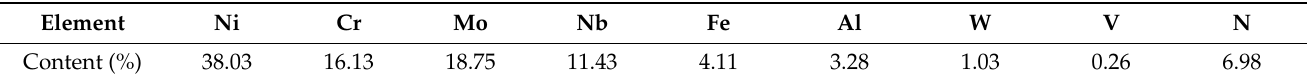
Figure 9. Surface and cross-sectional morphology of 3 nitrogen-containing low-nickel weld cladding after corrosion for 10 h. ( a ) SEM surface morphology. ( b ) High magnification of area A. ( c ) EPMA section morphology and corresponding elemental maps. Table 4. Surface element content of nitrogen-containing low-nickel weld cladding 3 after corrosion for 10 h.